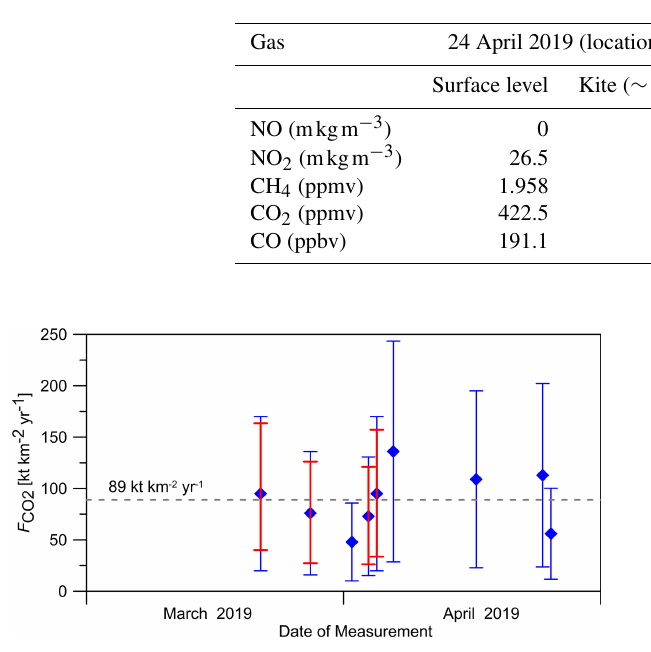
Figure 10. Daily mean values of the CO 2 area flux F obtained dur- ing the city campaign. Error bars show the uncertainties of F values estimated for the 9 and 4d datasets (blue and red,